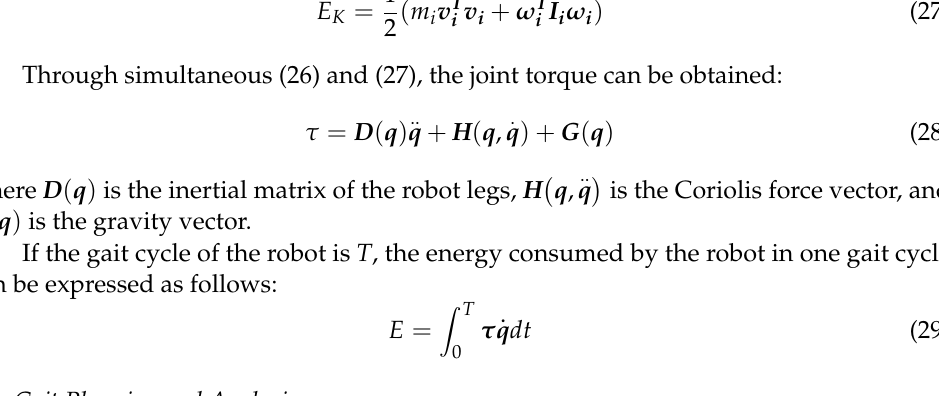
Figure 7. Leg dynamics analysis model.